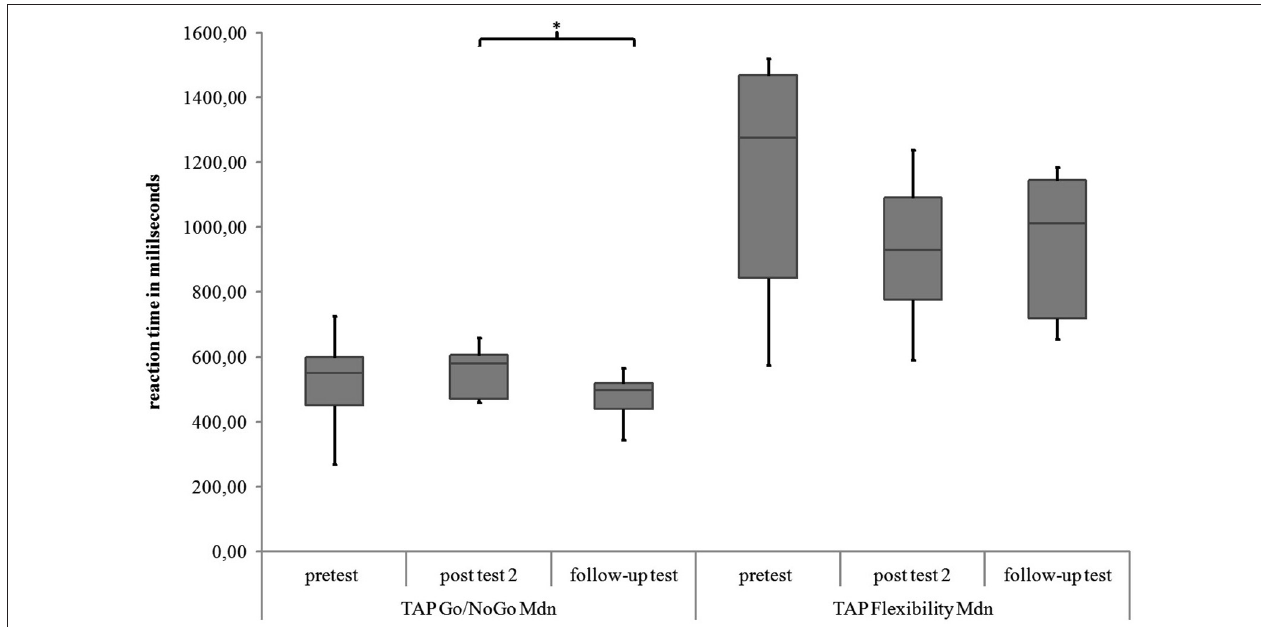
FIGURE 5 | Medians of reaction times for the TAP subtests Go/NoGo and Flexibility for all measurement points . Middle line of boxes = median, box = interquartile range, error bars = minimum respectively maximum, * = significant.